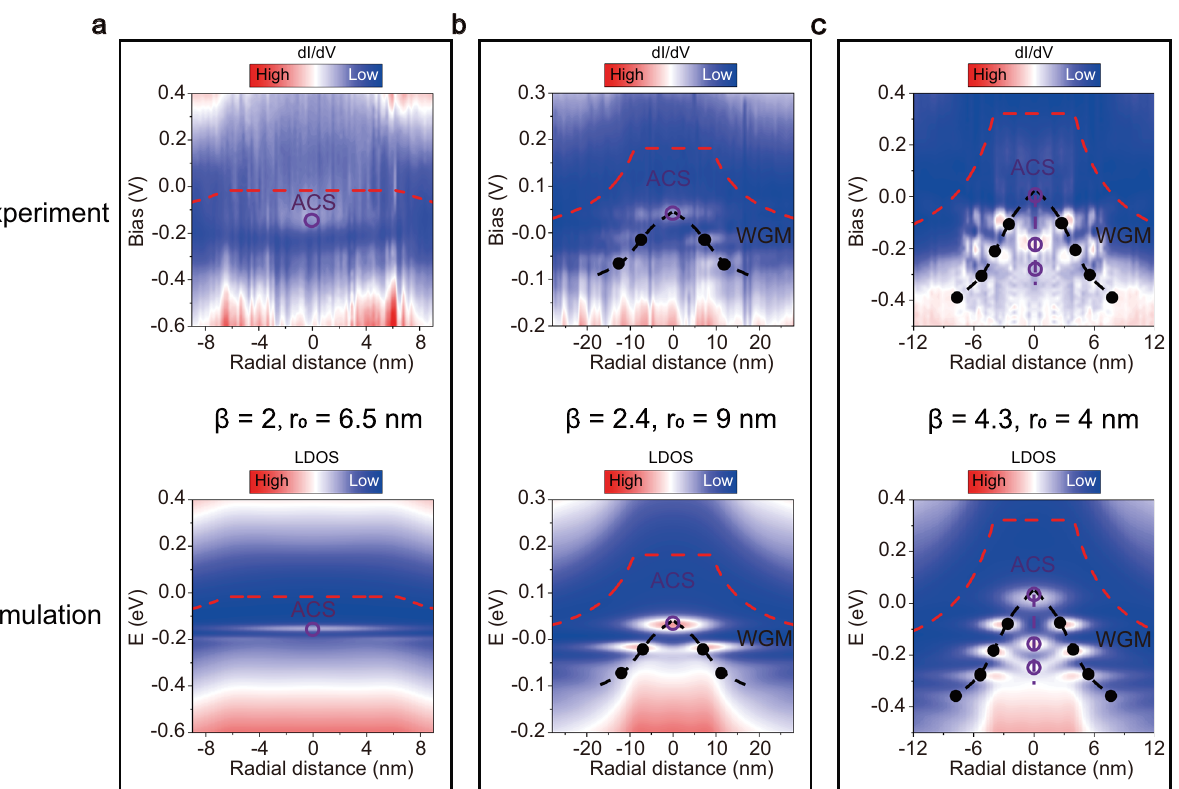
Fig. 2 Coexistence of whispering-gallery modes (WGMs) con fi nement and atomic collapse states (ACSs) in the GQDs. Top of a – c , The radially d I /d V spectroscopic maps of different GQDs. Bottom of a – c , The calculated space-energy maps of the LDOS of different GQDs with different value of β and r 0 . The red dotted lines indicate Dirac point energy. The black solid dots indicate the quasibound states via the WGM con fi nement, and the purple hollow dots indicate the